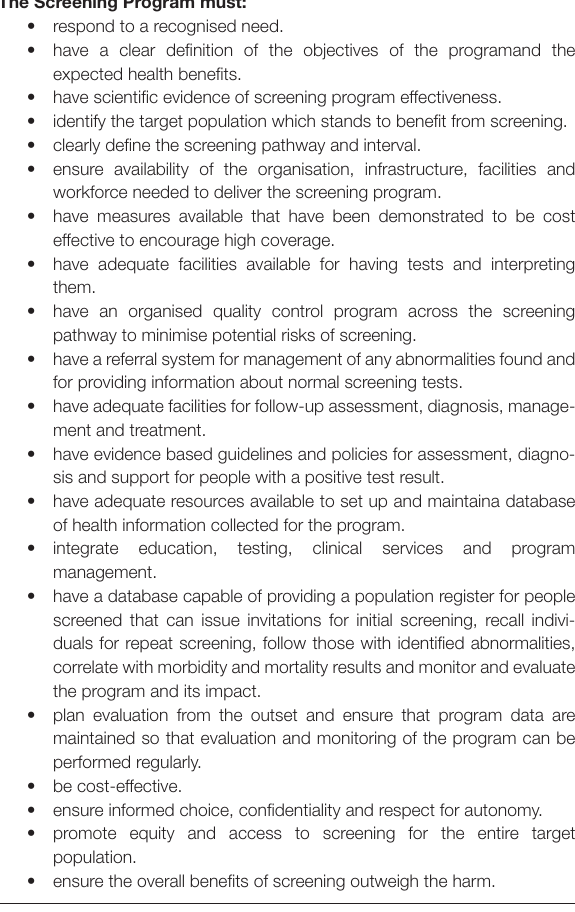
BOX 2 | Australian population-based screening framework: screening program requirements